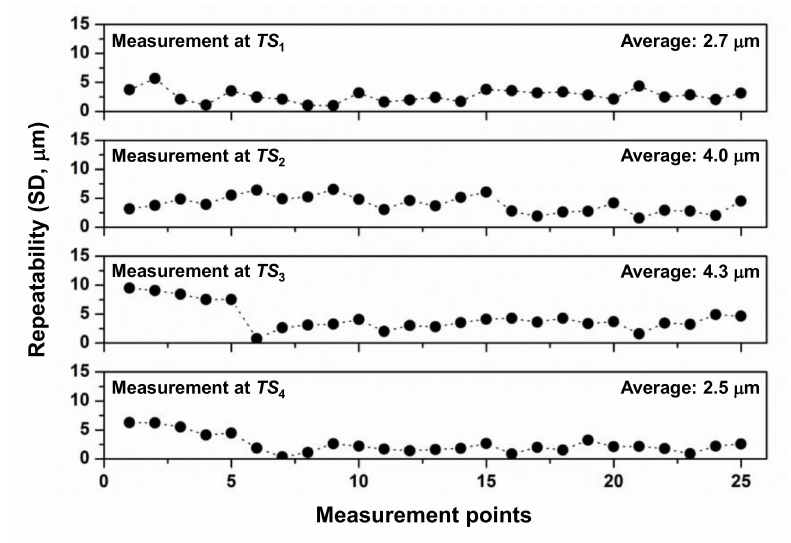
Figure 8. Repeatability of absolute distance measurement for 25 target points used for self-calibration (SD: standard